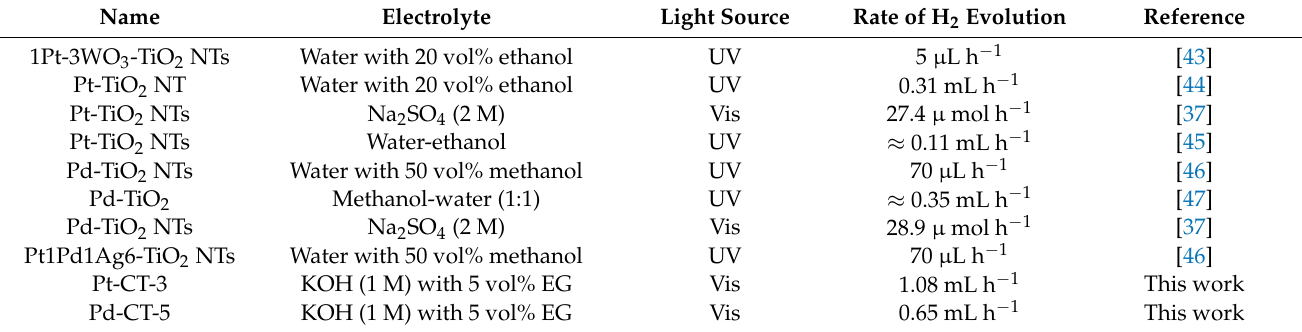
Table 1. Comparison of H 2 evolution using noble-metals surface decorated TiO 2 -based nanocom- posites.